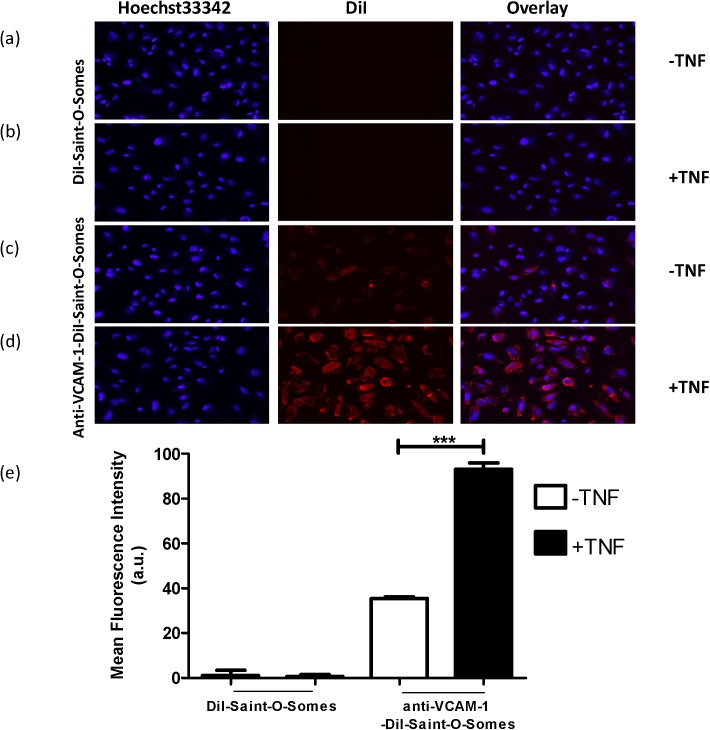
Anti-VCAM-1-DiI-Saint-O-Somes bind to AB8/13 cells.DiI-SAINT-O-Somes (a, b) and anti-VCAM-1-DiI-SAINT-O-Somes (c, d) were incubated for 4 h at 37°C with AB8/13 cells in the absence (-) (A, C) or presence (+) (b, d) of TNFα (10 ng/ml; 24 h). The nuclei were stained blue with Hoechst 33342. Original magnification 200x. (e) Quantification of binding of anti-VCAM-1-DiI-SAINT-O-Somes or DiI-SAINT-O-Somes to AB8/13 cells. Cells incubated in equal volumes of HN buffer were taken as controls and their values were subtracted from test samples. The mean fluorescence intensity (MFI) was determined by FACS and analyzed by FlowJoTM. *p <0.001.